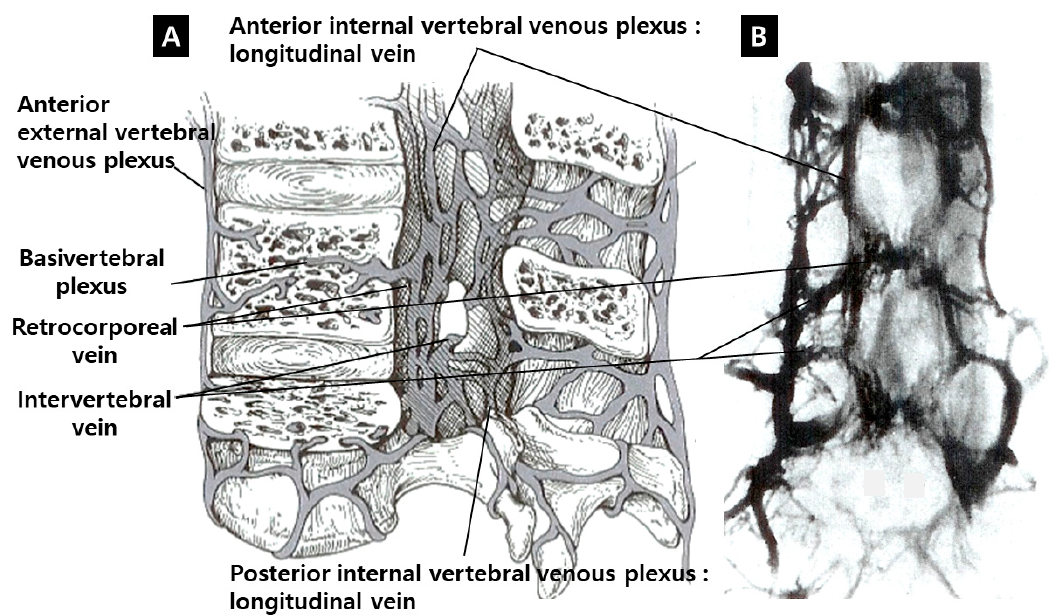
Figure 1. Three-dimensional structures of internal and external vertebral venous plexus. ( A ) The vertebral venous plexus was divided into three intercommunicating divisions: internal vertebral, external vertebral and basivertebral plexus; ( B ) venography on a coronal plane. (Reproduced with permission from Gregory D. Cramer and Susan A. Darby, Clinical Anatomy of the Spine, Spinal cord and ANS 3rd ed.; published by Elsevier, 2014).